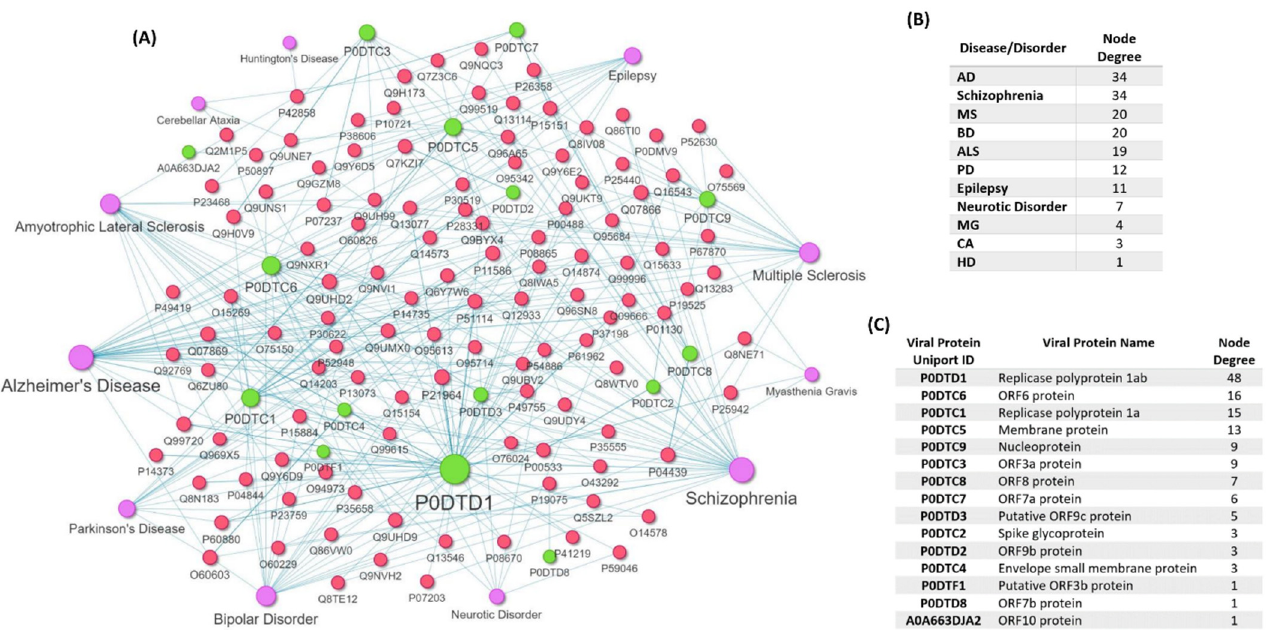
Figure 5. Disease-Associated Variant Genes/Proteins Interacting with SARS-CoV-2 Proteins . ( A ) Heterogenous subnetwork of the COVID-19-host PPI network indicating the human proteins that also have disease-associated variant genes/proteins for the eleven diseases/disorders (MS, AD, PD, ALS, HD, CA, MG, Schizophrenia, Neurotic Disorder, BD, Epilepsy) and are also targeted by the 15 viral proteins of SARS-CoV-2. The red nodes represent human disease-associated variant genes/proteins that are also targets of SARS-CoV-2 viral proteins, the purple nodes are diseases/disorders, and the green nodes are SARS-CoV-2 viral proteins. Node size is proportional to its degree, which indicates the number of connected edges to each node. ( B ) Node degree of each of the eleven diseases/diseases, indicating the number of human proteins with disease-associated variant genes that are targeted by SARS-CoV-2 proteins. ( C ) Node degree of each SARS-CoV-2 viral proteins, indicating the number of disease-associated variant genes that each viral protein targets.